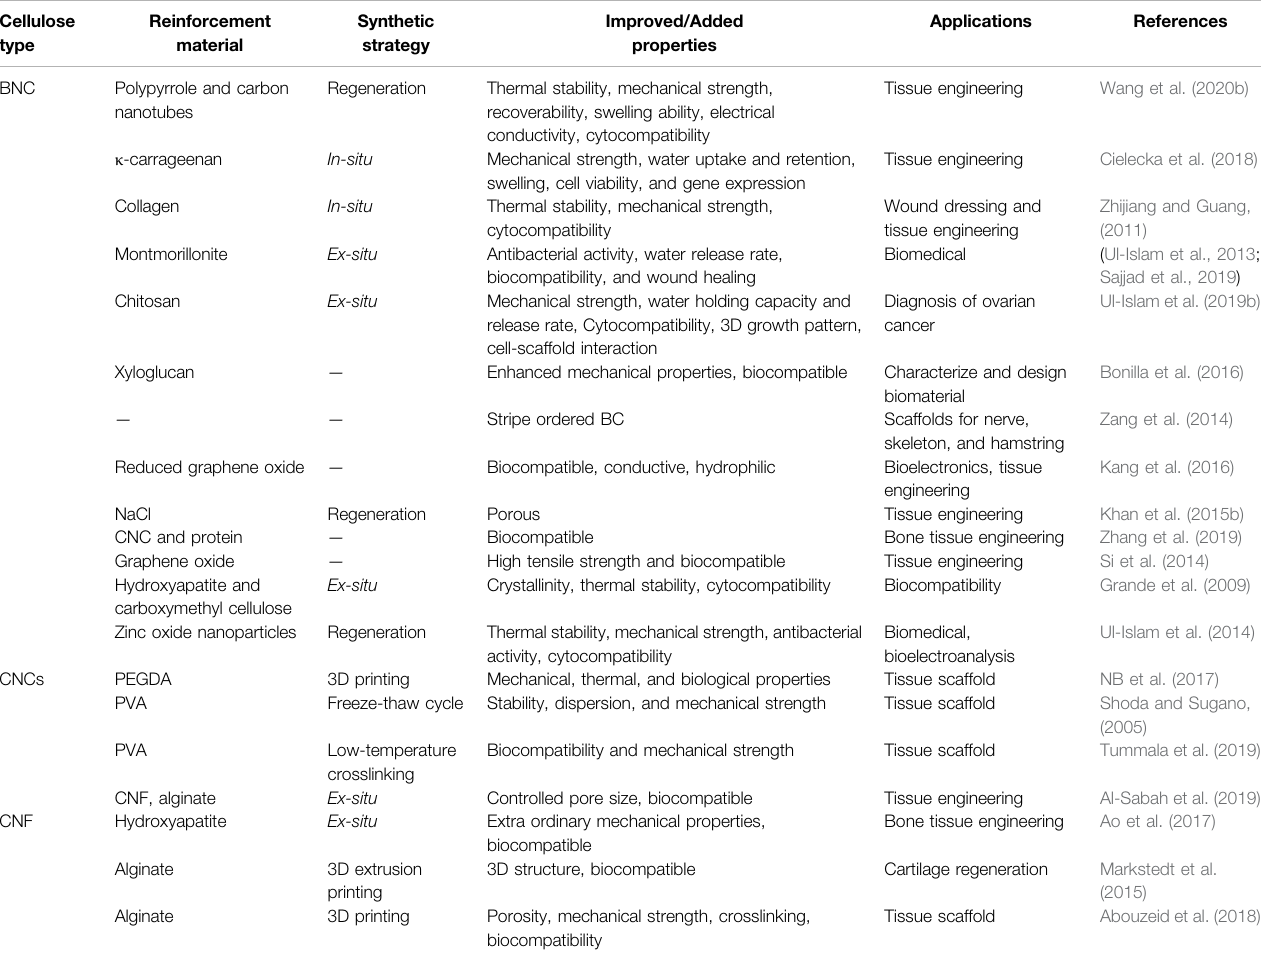
TABLE 2 | The improved properties and targets of different nanocellulose-based tissue engineering scaffolds. Cellulose